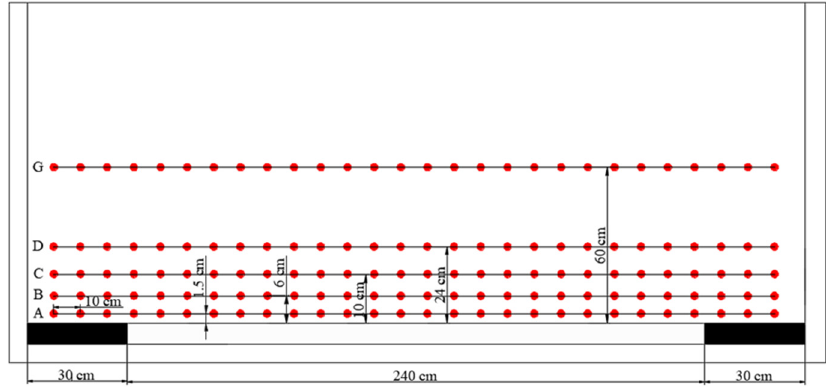
Figure 4. Layout of physical model displacement measuring line.